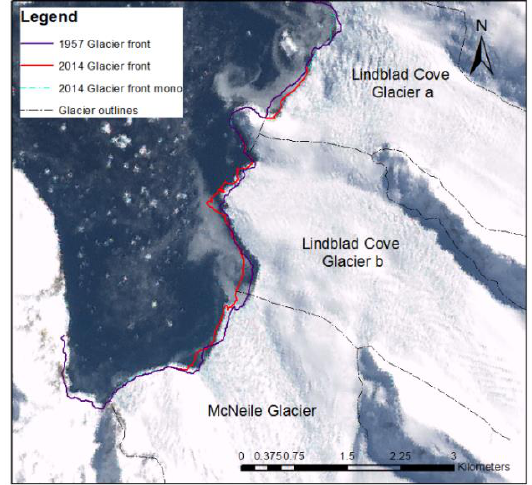
Figure 3. Coastal change of the glaciers between 1957 and 2014 overlain on LIMA mosaic (composed of images acquired between 1999 and 2003). UTM Zone 21S.